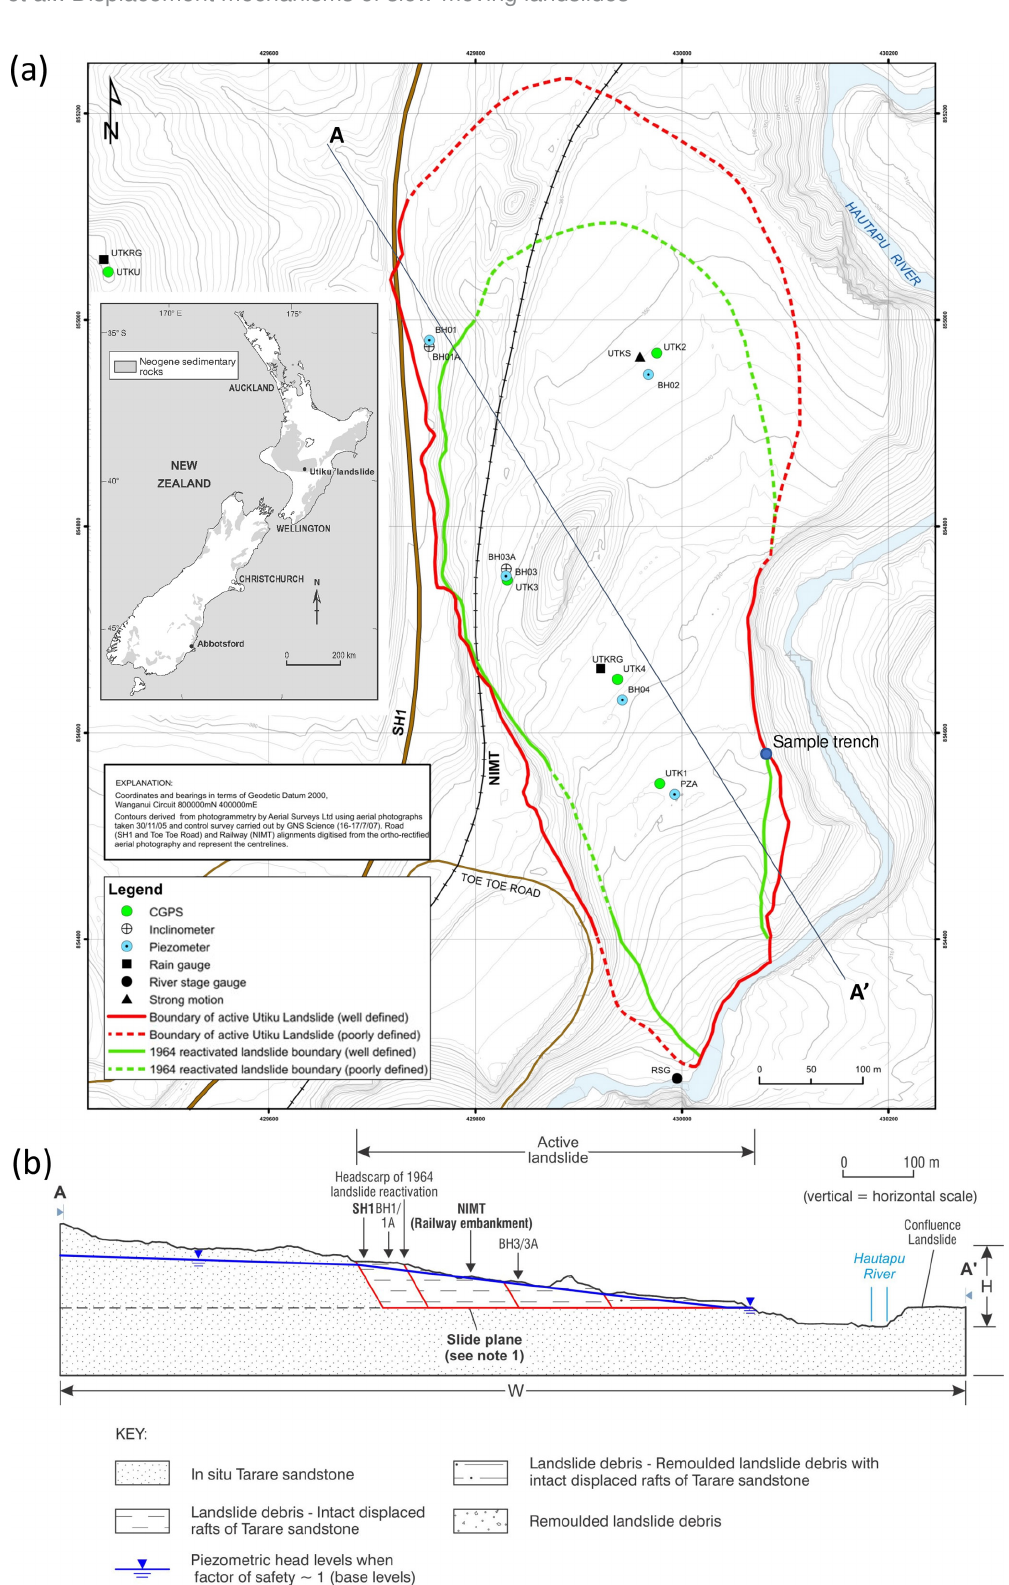
Figure 1. (a) Location of the Utiku landslide in North Island, New Zealand, the location of monitoring equipment installed on the landslide in September 2008 and the location of the trench from which samples of the slide surface were taken. (b) Cross section A–A (cid:48) through the landslide, refer to panel (a) for the location of the section. Note 1: slide plane formed within a thin (10–20mm) layer of smectite-rich clay. www.earth-surf-dynam.net/7/707/2019/ Earth Surf. Dynam., 7, 707–722,